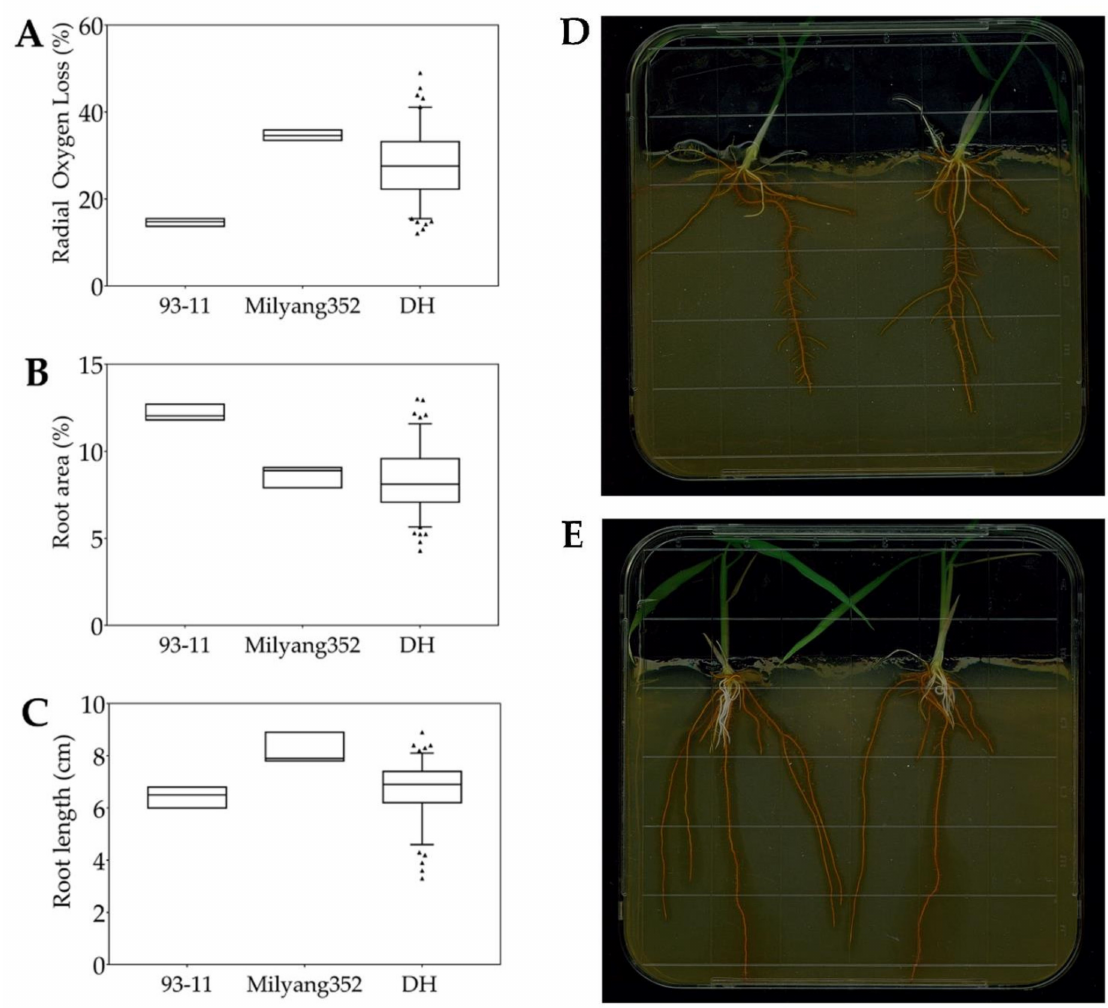
Figure 2. Genotype–phenotype correlation of the mapping population and their parental lines under FeS treatment. ( A ) The box plot shows the effects of FeS application on ROL rate of 93-11 (P1, indica ), Milyang352 (P2, japonica ), and that of a doubled haploid (DH) rice population ( n = 117), ( B ) box plot showing the root area (RA), and ( C ) root length (RL) of the same mapping population, under the same conditions, ( D ) ROL phenotypes of 93-11 and ( E ) Milyang352. Pictures were scanned 14 days after sowing on FeS